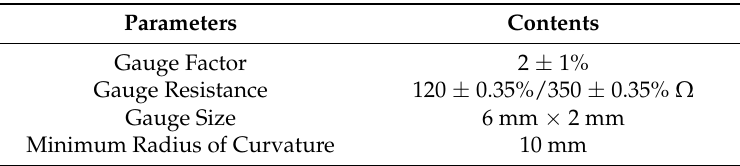
Table 2. Strain gauge specifications.